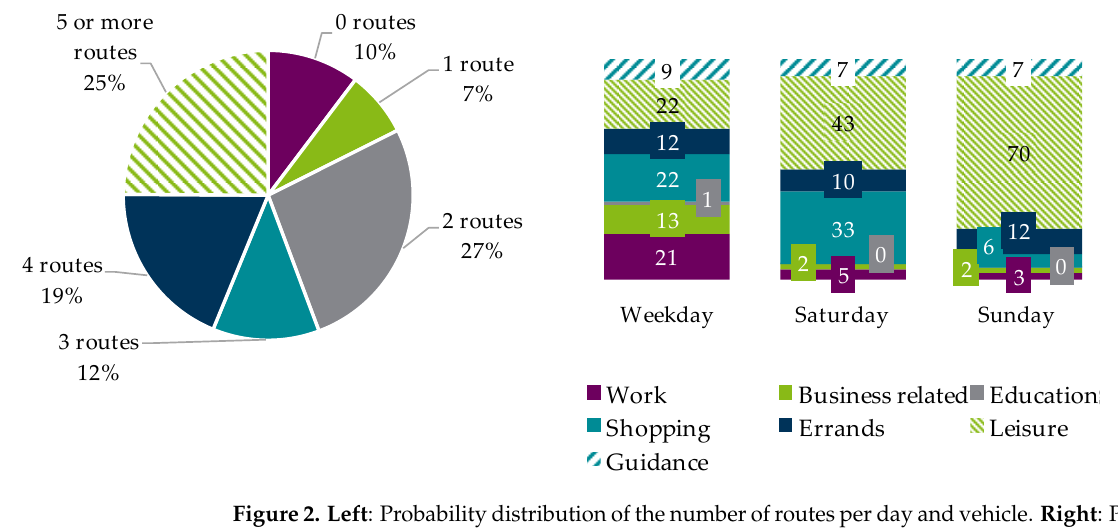
Figure 2. Left : Probability distribution of the number of routes per day and vehicle. Right : Percentage of the purpose of the daily routes for different weekdays based on [28].